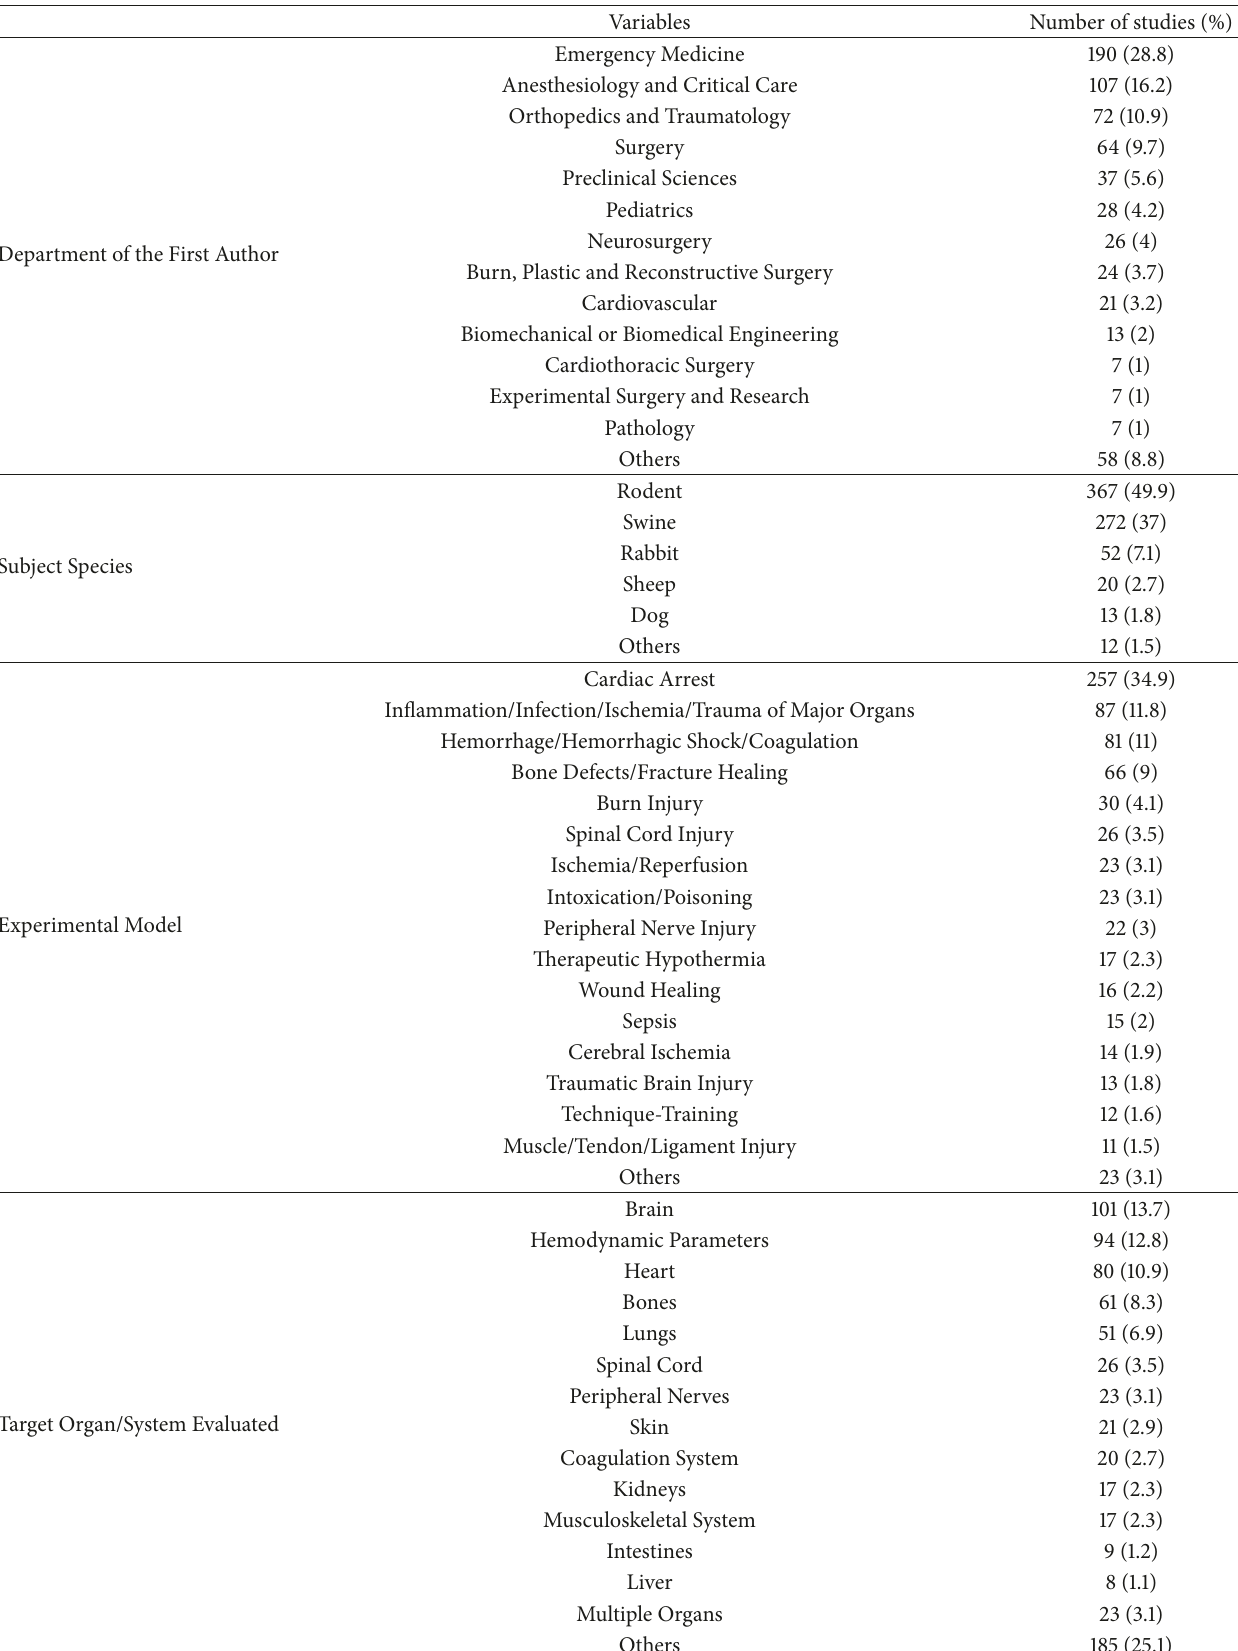
Table 3: Characteristics of the experimental studies subjected in the